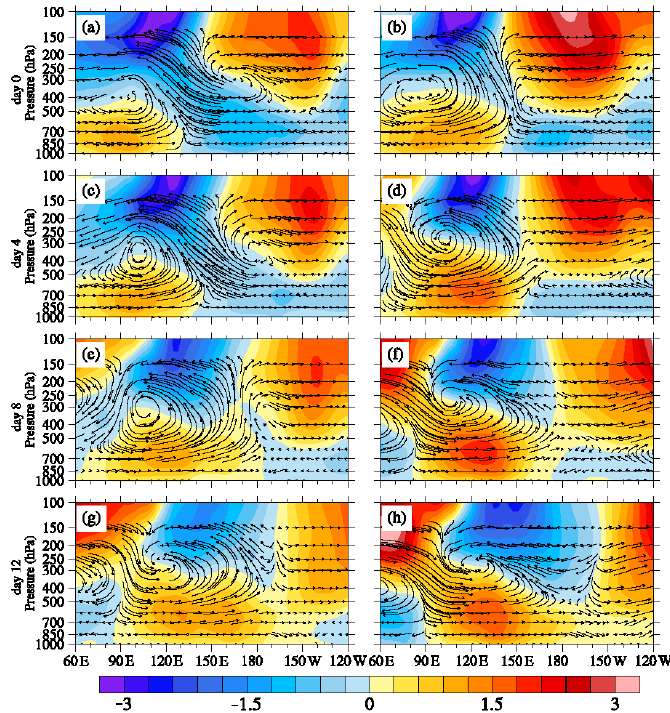
Figure 10. MJO zonal vertical circulation (vectors, magnified 500 times in the vertical direction, colors represent zonal velocity) lag regressed onto the MC–MJO OLR index during the positive (left row) and negative (right row) phases of PIOAM, day 0 positive ( a ) and negative ( b ), day 4 positive ( c ) and negative ( d ), day 8 positive ( e ) and negative ( f ), and day 12 positive ( g ) and negative ( h ).